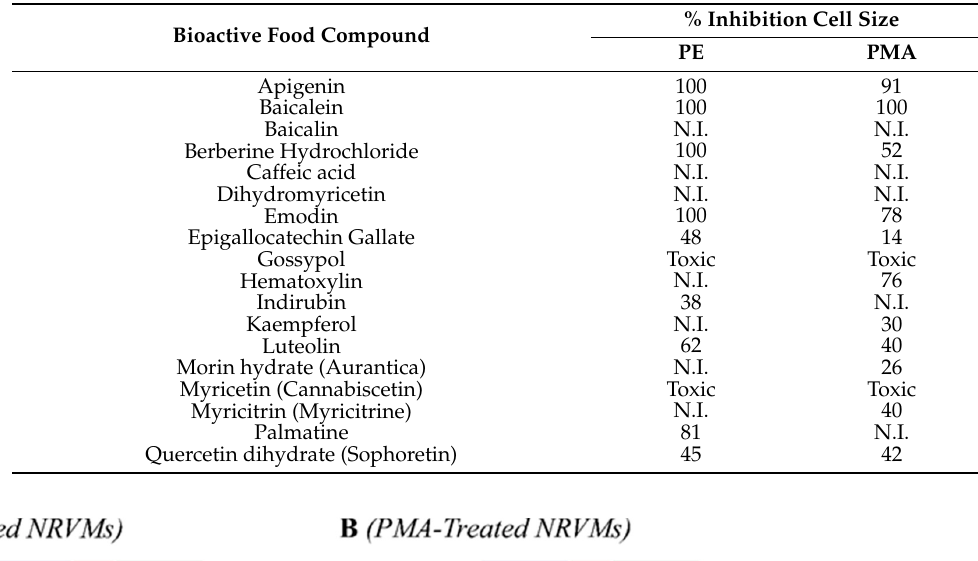
Table 1. Dietary inhibitors of Cardiac hypertrophy.